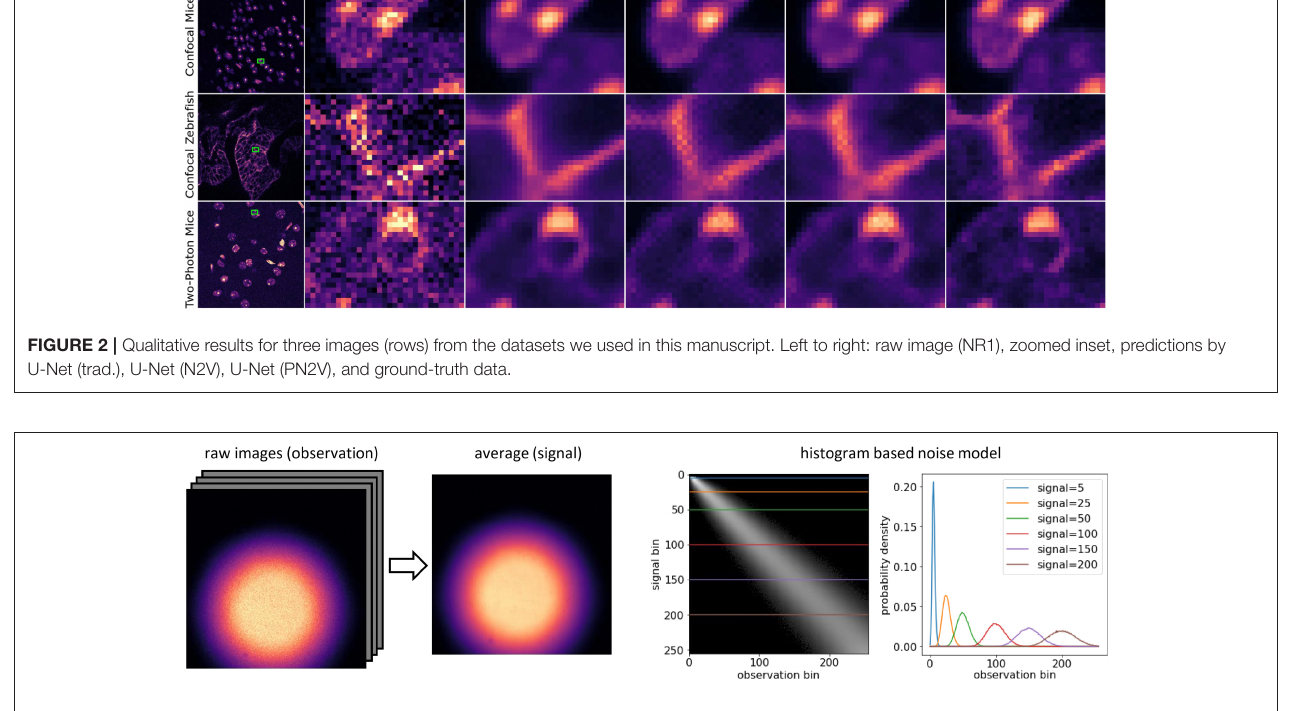
FIGURE 3 | Recording a histogram based noise model for a particular microscope. (Left) A noise model can be calculated from a stack of calibration images, showing any fixed content that covers the range of signals we are interested in. Noise models capture the noise property of the camera and are sample independent. In most microscopes, one can collect a calibration sequence without even having a sample to image. The example shows an out-of-focus, halfway closed field diaphragm. The only purpose of these images is to create data that contains a non-saturated range of image intensities that cover the desired signal domain. Here we collect a set of 100 noisy raw images (observations). Provided that nothing in our setup moved, we can estimate the corresponding true signal by averaging. (Right) Using the pairs of clean signal and noisy observations we can now produce a 2D histogram (see section 5.2), with each row corresponding to the distribution p ( x i | s i ) for a particular signal s i . The plot shows these distributions for six different signal values, as indicated by